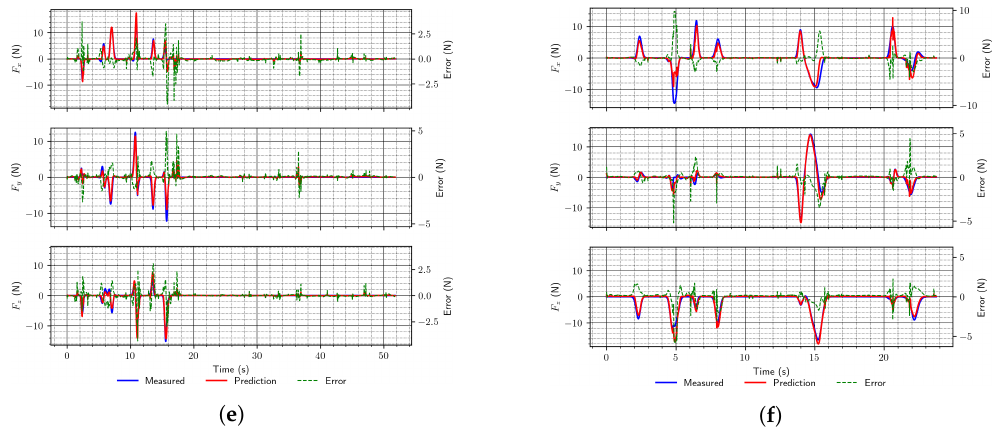
Figure 5. Two random examples ( a , c , e and b , d , and f , respectively) of end-effector force predictions using the simulation data test set for different types of proposed network architectures. ( a ) MLP (arch. #2); ( b ) MLP (arch. #3); ( c ) Convolutional (arch. #4); ( d ) Convolutional (arch. #6); ( e ) LSTM (arch. #7); ( f ) LSTM (arch. #9).